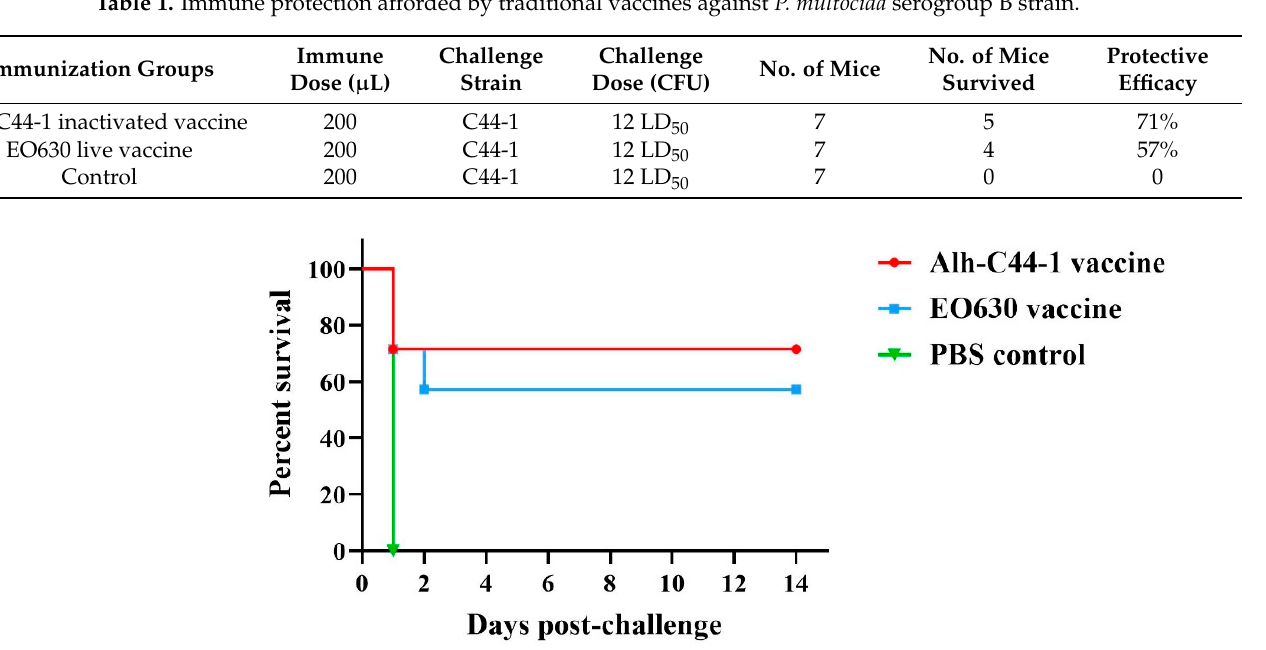
Table 1. Immune protection afforded by traditional vaccines against P. multocida serogroup B strain.